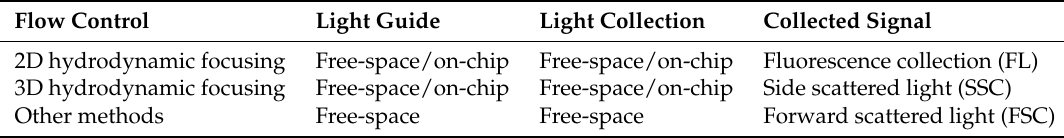
Figure 1. System setup of an optofluidic device (also referred to as photonic-microfluidic integrated device)-based microflow cytometer. Laser light is focused through on-chip lenses, and side scattered light (SSC) and fluorescence light (FL) signals are detected via free-space lens system. Light signals are amplified by a photomultiplier tube (PMT), then data are analyzed by a data acquisition card (DAQ). Reproduced from [20] with kind permission from Wiley. Table 2. Techniques related to the performance of an optofluidic microflow